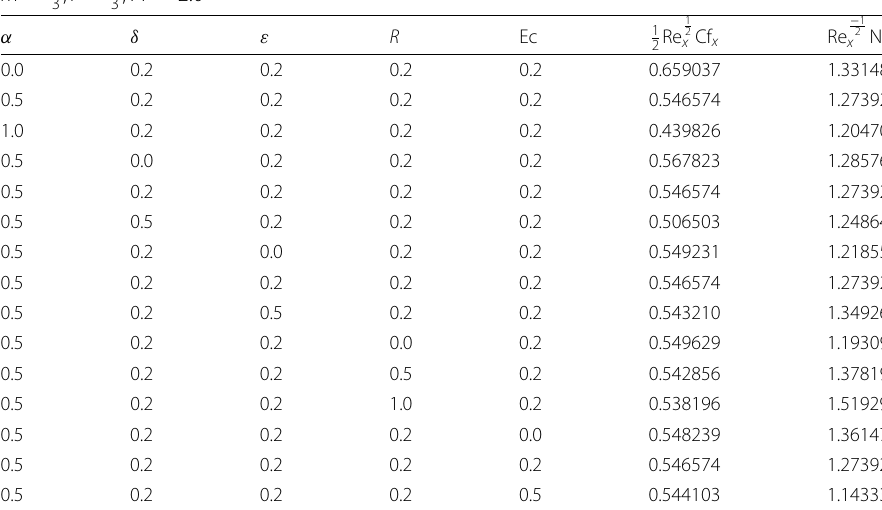
− 1 2 x Nu x for various values of α , δ , ε , R, and Ec with